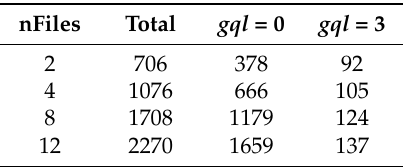
Figure 1. Number of gap-sites observed in samples of different sizes (STAR). Table 1. Number of gap-sites from different sample sizes